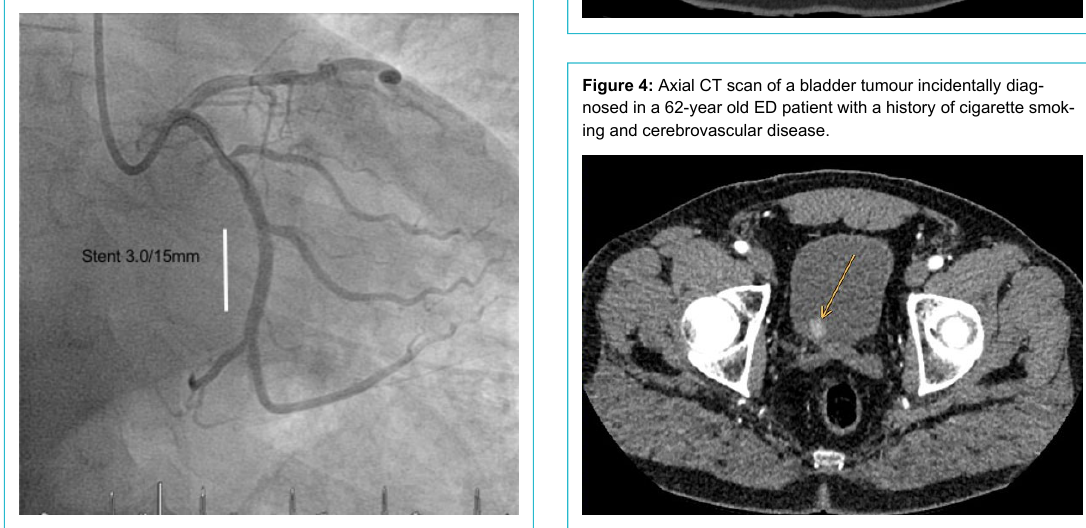
Figure 2b: Intra-arterial coronary angiogram after drug eluting stent placement.